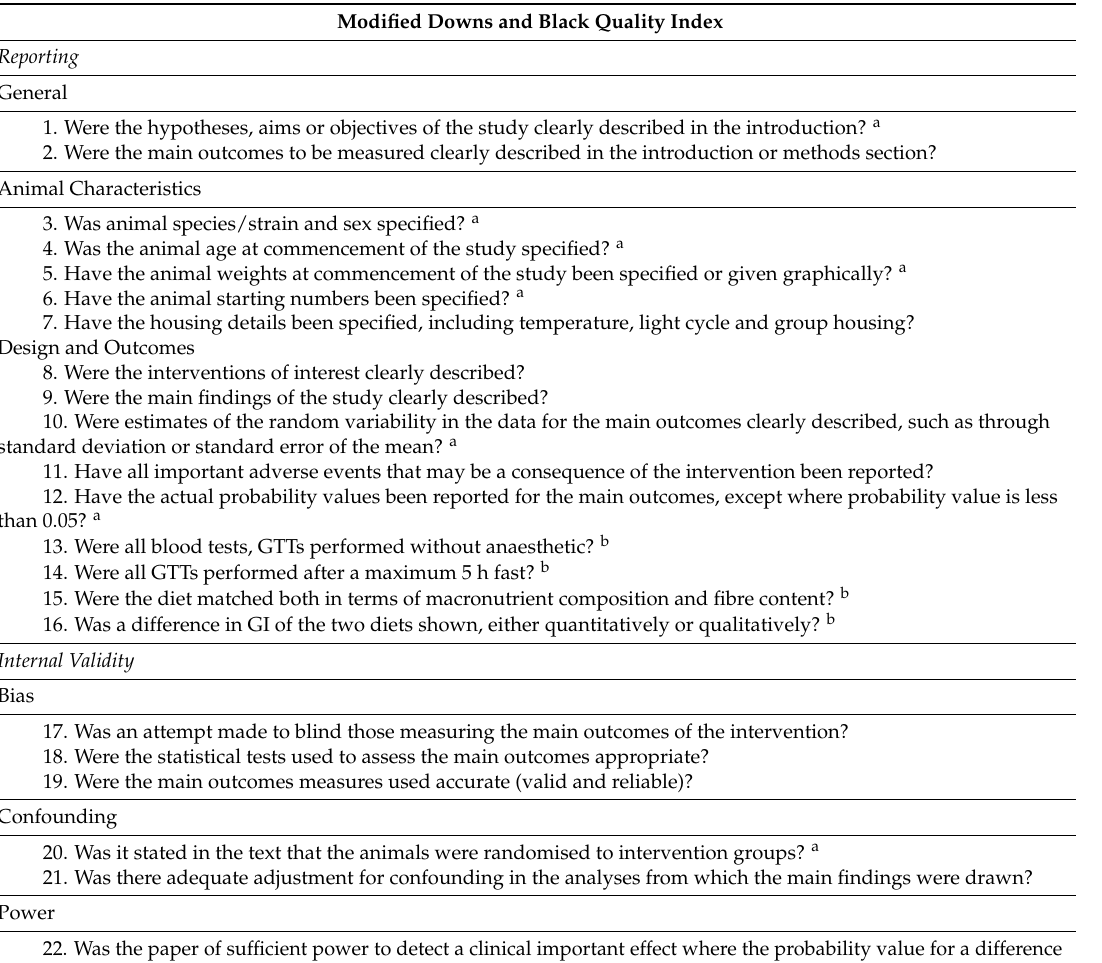
Table 3. Methodological Quality Assessment questions. MQA questions modified from Ainge et